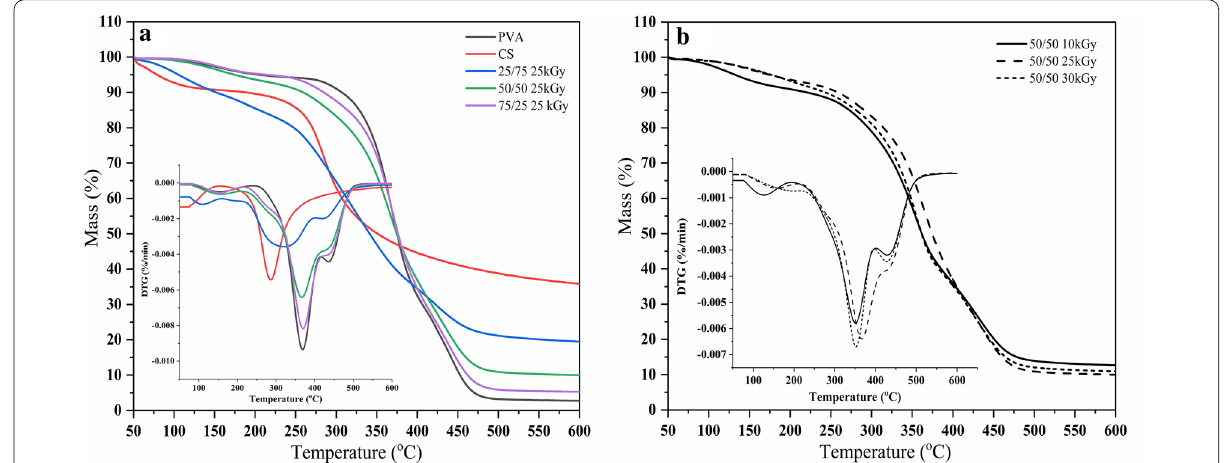
Fig. 5 a Typical TG and DTG curves of pure PVA, pure CS, and CS/PVA blended hydrogels at 25 kGy and b 50/50 CS/PVA at 10, 25, and 30